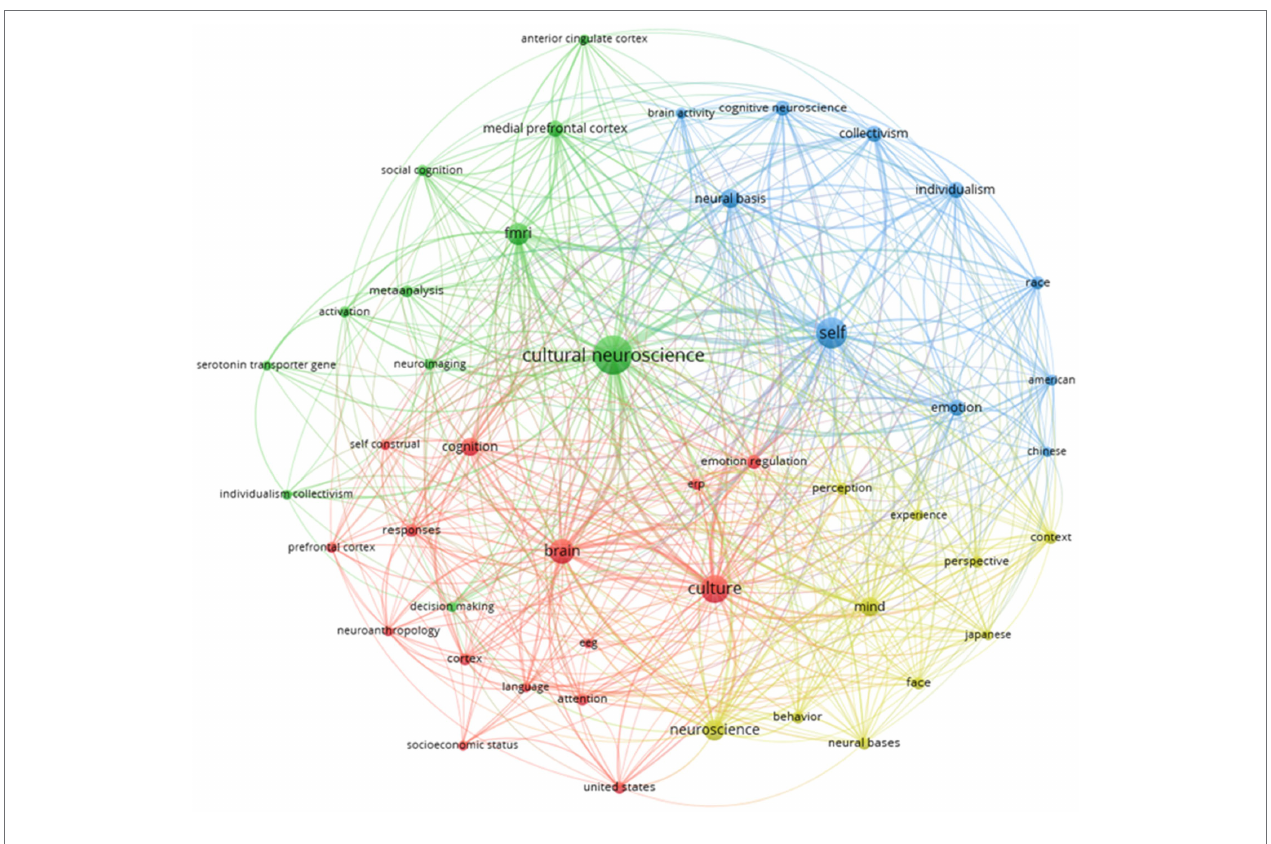
FIGURE 5 | Keyword network.